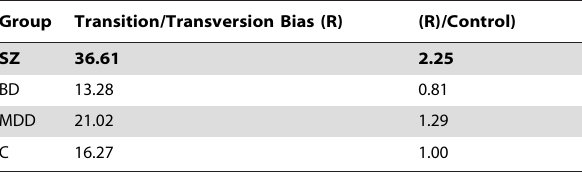
Table 5. Transition/transversion bias calculation for mtDNA coding sequences shows difference between SZ and control group